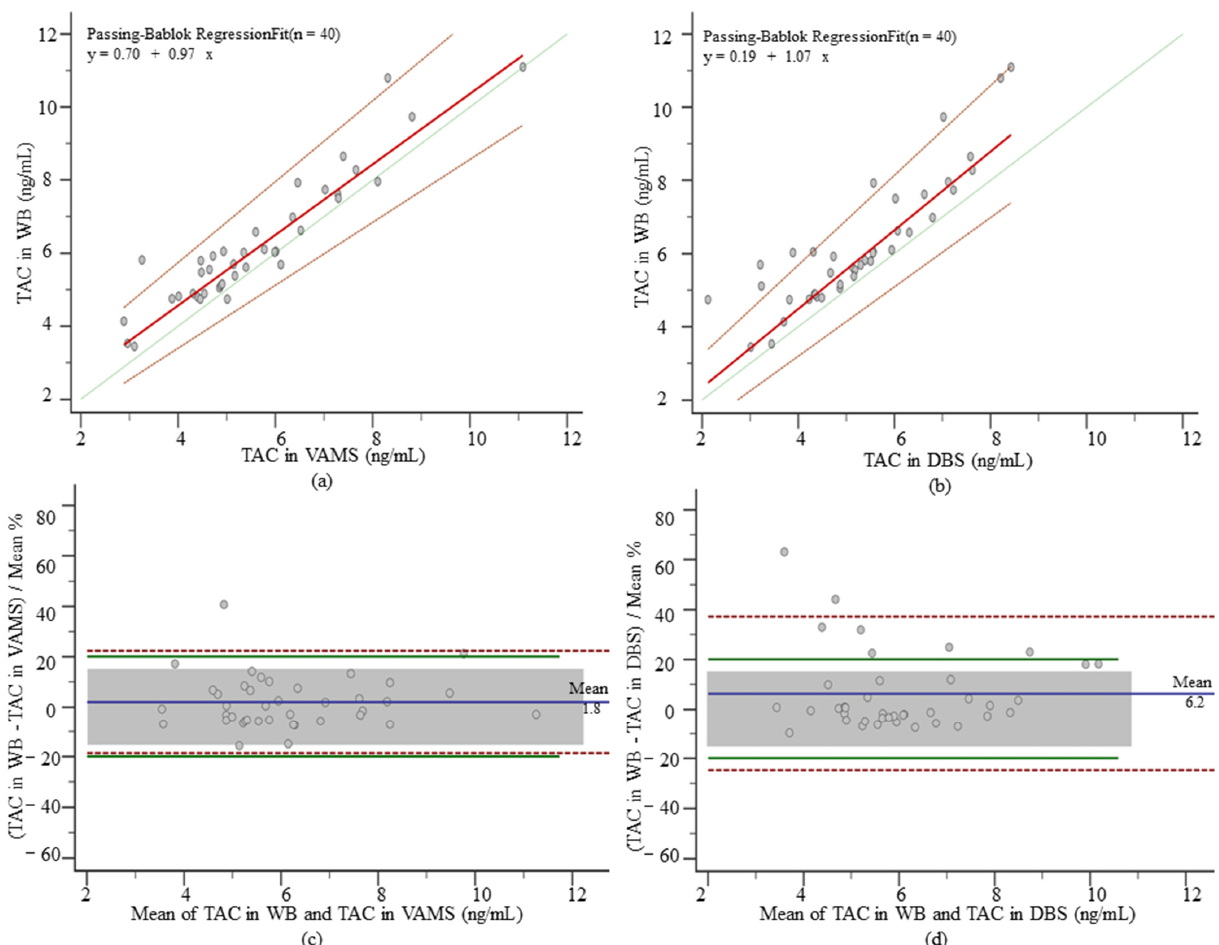
Figure 3. PB regression and Bland–Altman plot for TAC. ( a ) PB regression of TAC in VAMS samples and whole-blood samples, the solid red line is the regression line, the dashed red line is the 95% CI, and the solid green line is the identity; ( b ) PB regression of TAC in DBS samples and whole-blood samples; ( c ) Bland–Altman plot of whole blood TAC concentration and TAC concentration in VAMS. The blue solid line is the mean deviation, the red dashed line is the 95% CI, the green solid line is the APE acceptance limit (±20%), and the grey box is the set clinical acceptance limit (±15%), the following MPA and Cre as well; ( d ) Bland–Altman plot of whole blood TAC concentration and TAC concentration in DBS.